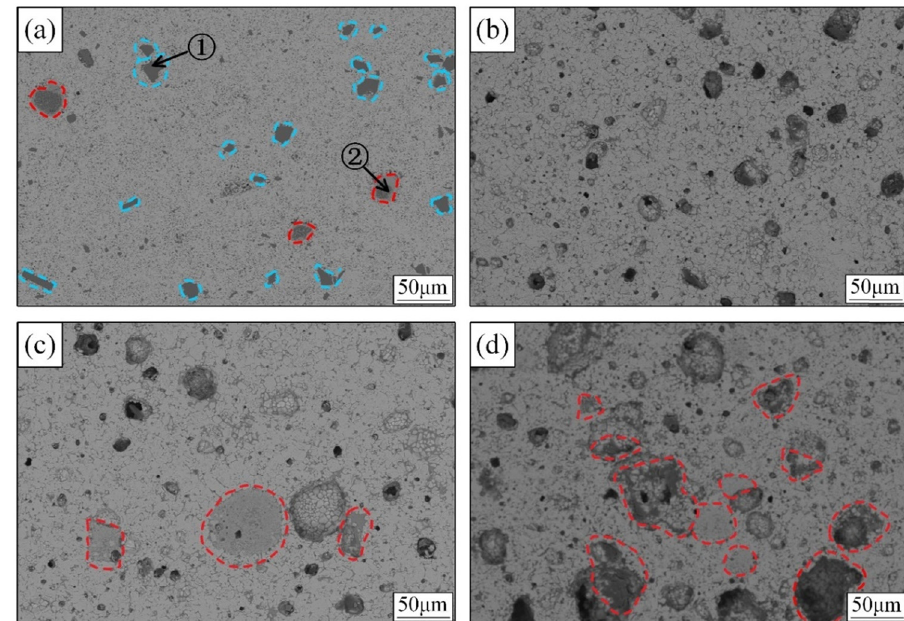
Figure 4: Back scatter electron image of fi red briquettes with di ff erent basicity values ① free SiO 2 ; ② solution ( a ) basicity = 0, ( b ) basicity = 0.33, ( c ) basicity = 0.83, and ( d ) basicity = 1.33.